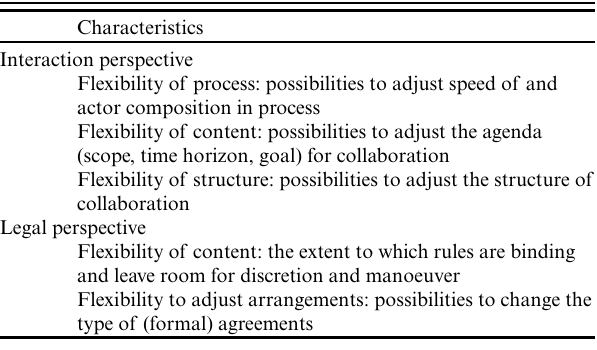
Table 1 . Summary of characteristics of flexible